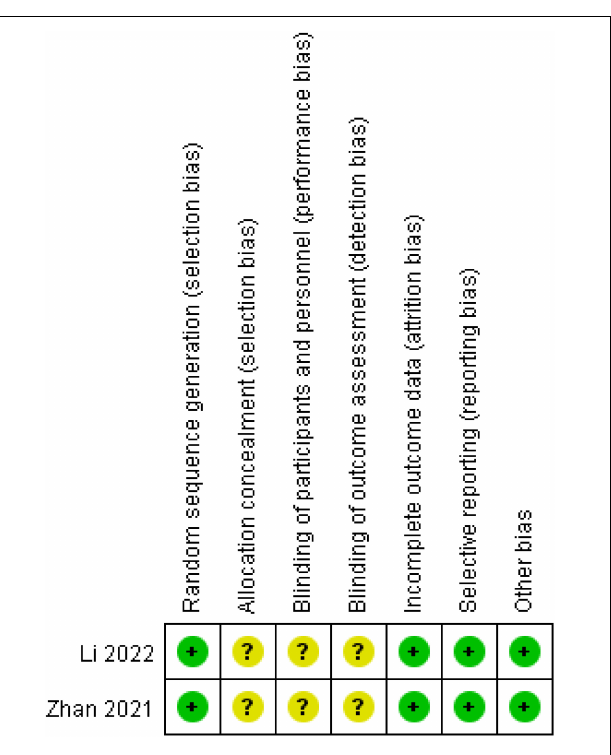
FIGURE 2 | Assessment of risk of bias in 2